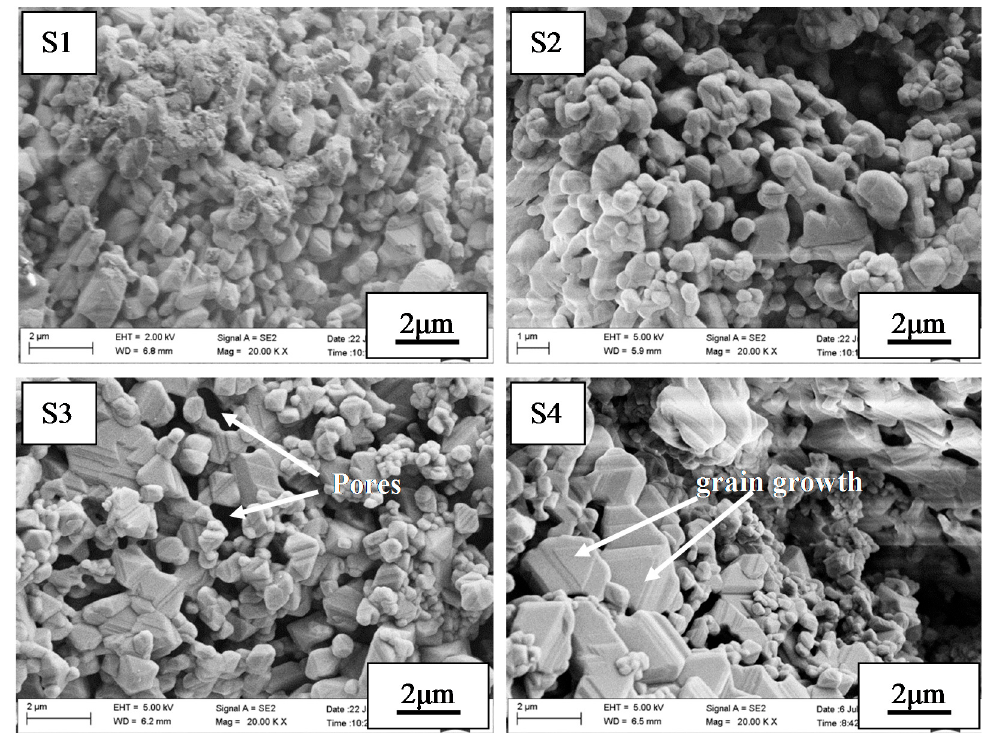
Figure 5. SEM images of fracture surface of the samples with different ratios of starting powders and deionized water sintered at 1600 °C for 4 h: (S1) 1:1; (S2) 1:1.5; (S3) 1:2; (S4) 1:2.5.